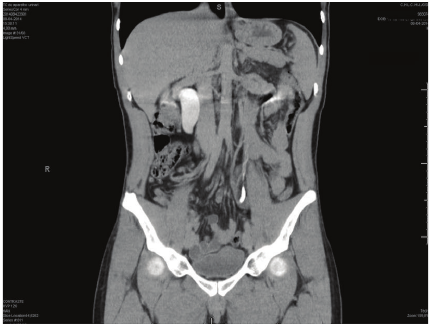
Figure 1: CT scan image showing the “reverse J” deformity.